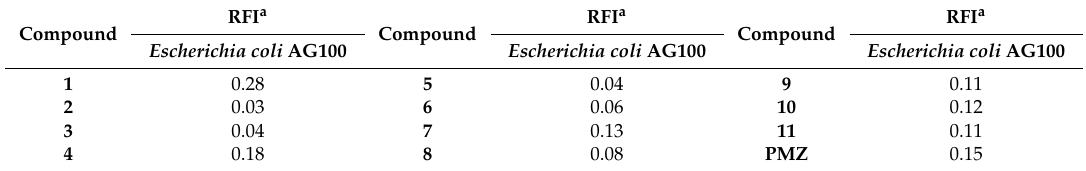
Table 4. Relative fluorescence index (RFI) for the e ff ect of selenocompounds and positive